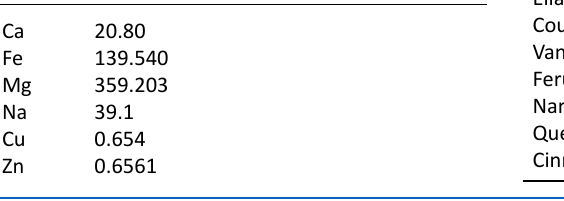
Table 2. Mineral constituents (ppm) of Commiphora myrrh . Resin extract